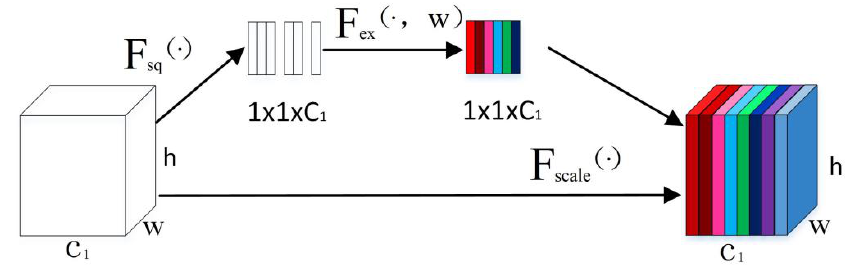
Figure 2. Squeeze and excitation module.